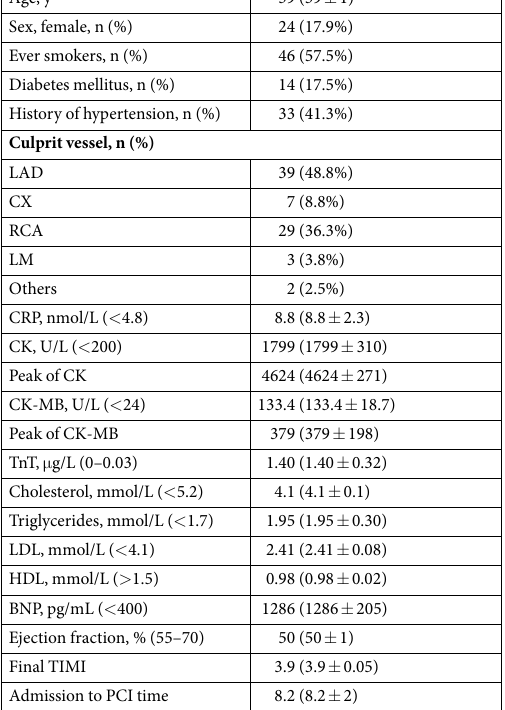
Table 1. Baseline of Patient characteristics. Data are presented as mean ± SD, or number (percent) of patients. Normal ranges are given in parenthesis. LAD, left anterior descending artery; CX, circumflex artery; RCA, right coronary artery; LM, left main coronary artery; CRP, C-reactive protein; CK, creatine phosphokinase; CK-MB, creatine phosphokinase isoform MB; TnT, troponinT; LDL, low density lipoprotein cholesterol; HDL, high density lipoprotein cholesterol; BNP, brain natriuretic peptide; TIMI, Thrombolysis in myocardial infarction; PCI, Percutaneous coronary